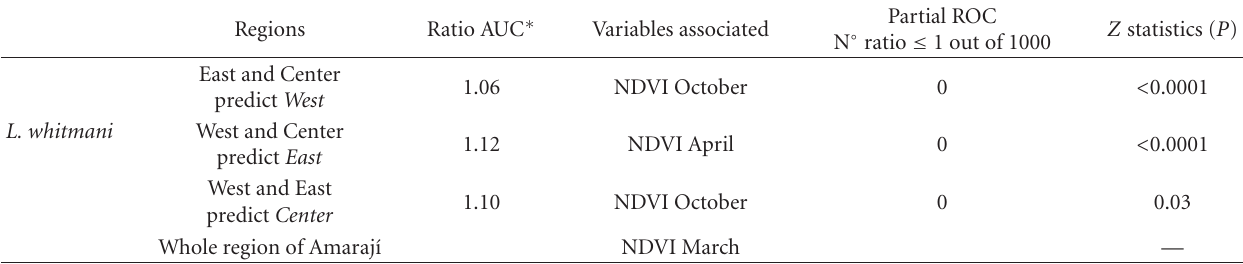
∗ Area under the ROC curve, expressed as a ratio of observed AUC to the area under the curve of random expectations. NDVI of March and August were omitted from models in light of their little contribution to fitness of